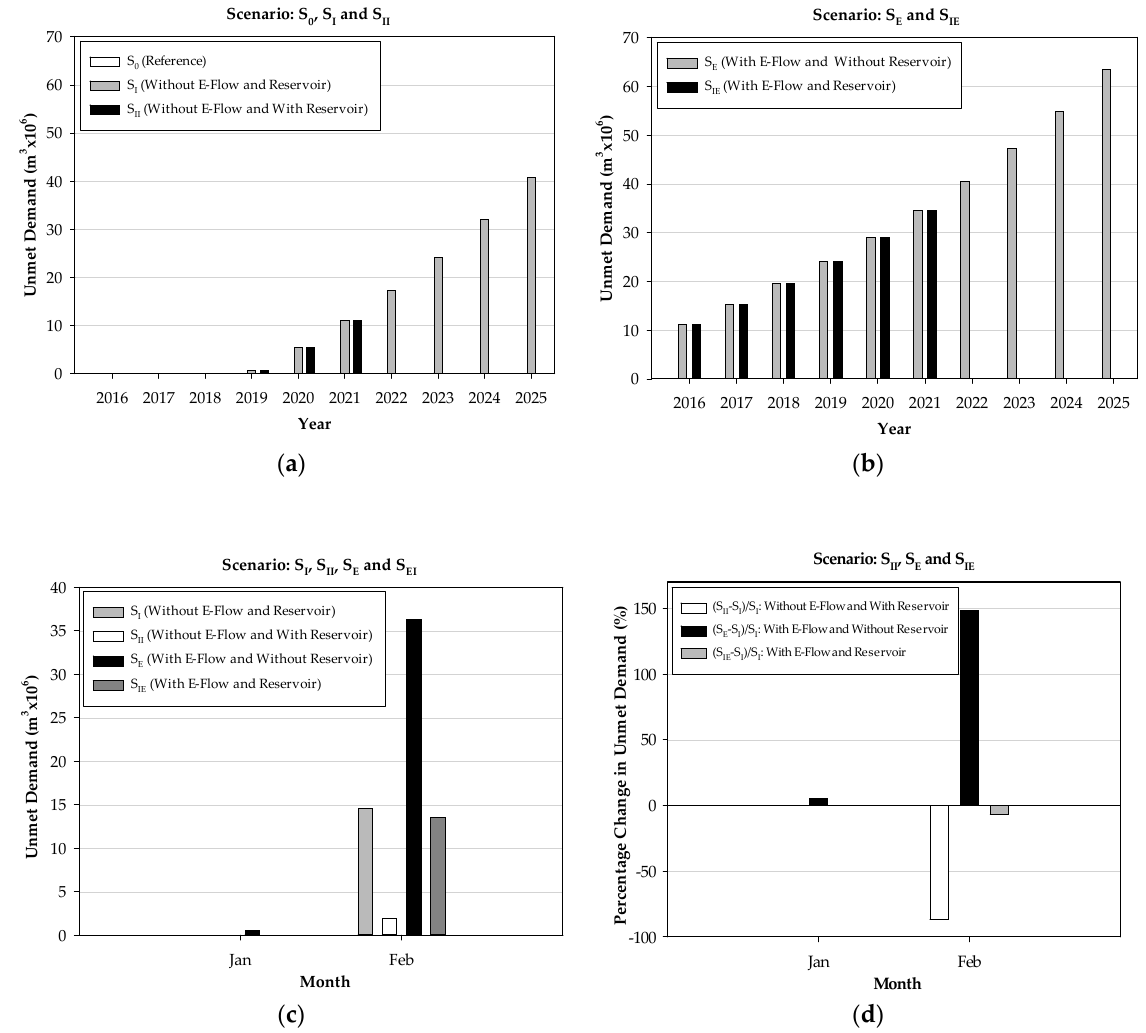
Figure 9. ( a ) The comparison of annual unmet demand between S 0 , S I and S II , ( b ) The comparison of annual unmet demand between S E and S IE , ( c ) The comparison of monthly unmet demand between S I , S II , S E and S IE , ( d ) The percentage change of monthly unmet demand in S II , S E and S IE .